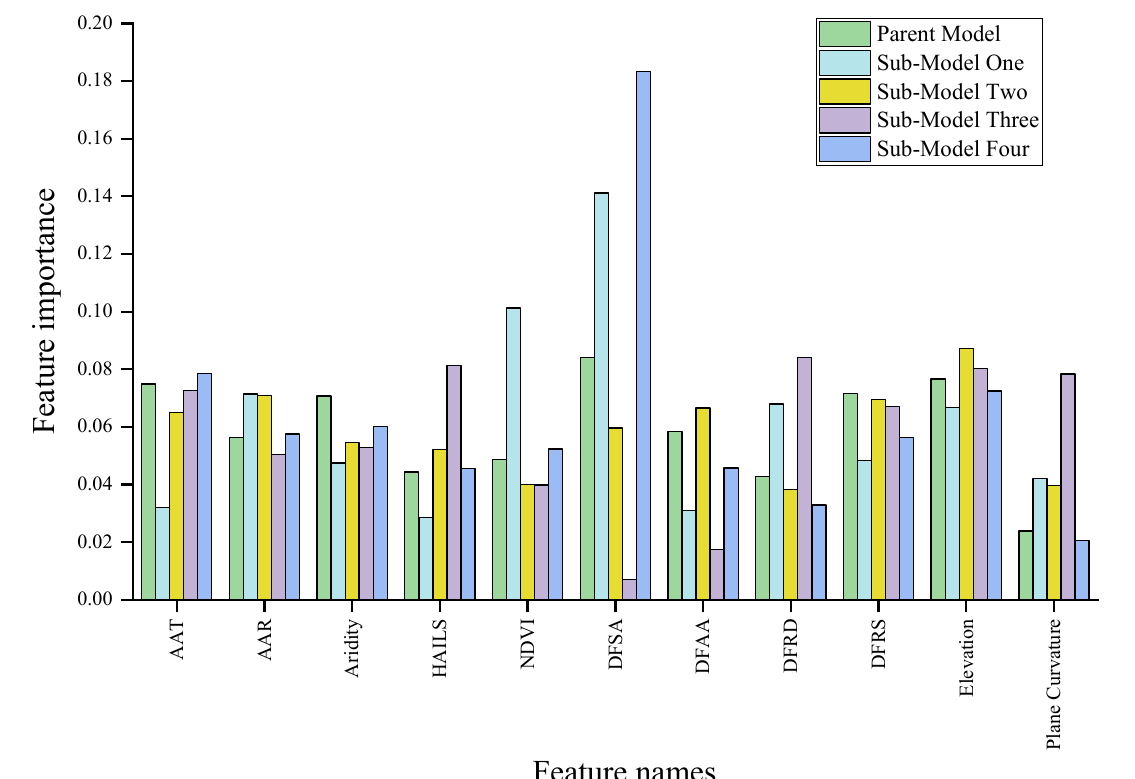
Figure 11. Top five important factors of different models. AAT: Average annual temperature; AAR: Average annual rainfall; DFSA: Distance from syncline axis; DFAA: Distance from anticline axis; DFRD: Distance from road; DFRS: Distance from rivers.